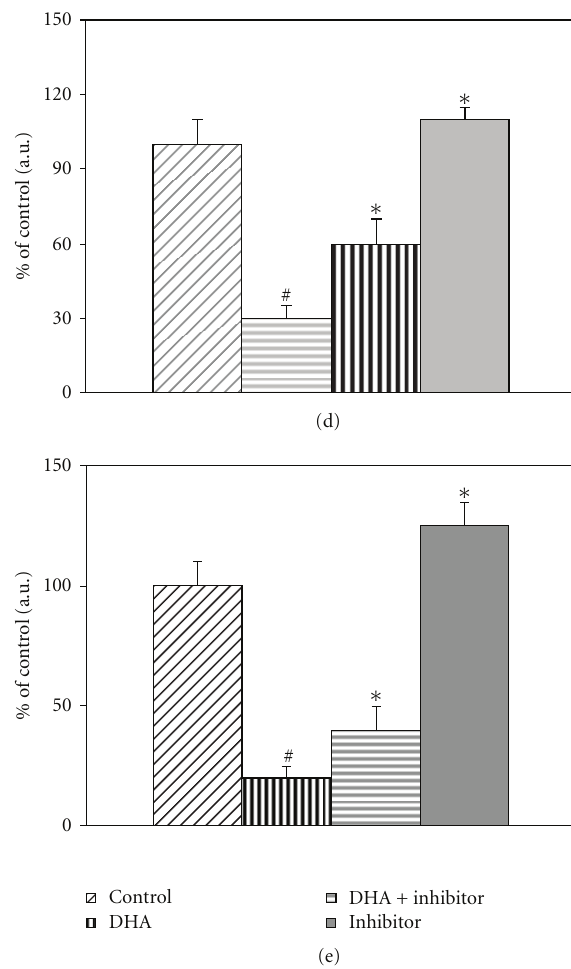
Figure 2: SRF expression in mouse adipocytes treated with DHA. Equal volumes (1-2ml) of freshly isolated adipocytes were incubated in DMEM-HEPES supplemented with penicillin-streptomycin, containing 1% BSA. Adipocytes were treated as specified control, 25 μ M DHA, 25 μ M DHA plus 1.5 μ M GW9662, or 1.5 μ M GW9662 alone for 16h. Cells and medium were separated and analyzed for SRF